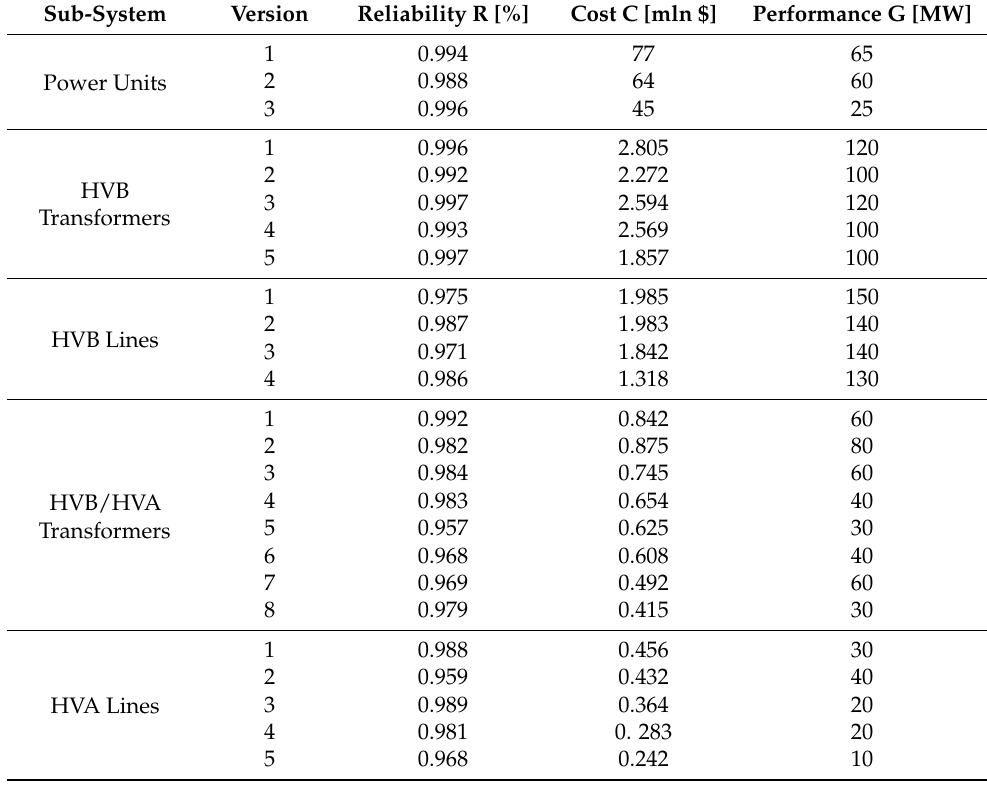
Table 1. Characteristics of the system elements available [56].